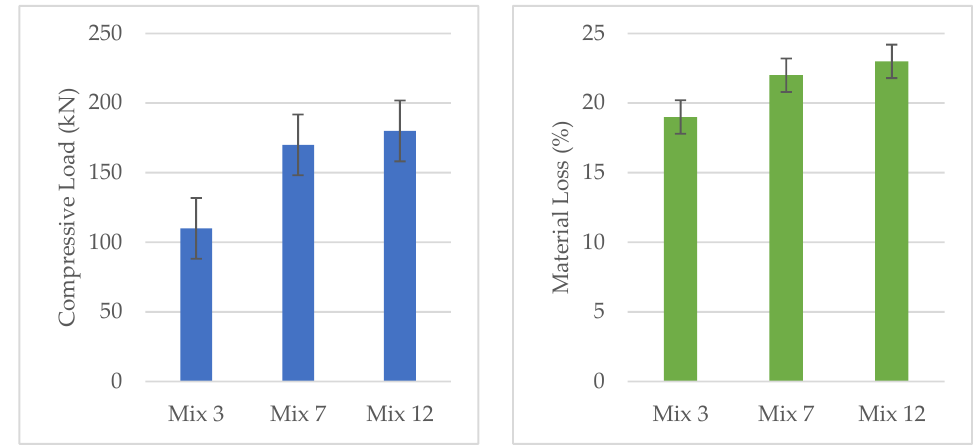
Figure 6. Results of compression and material loss based on the principle of Cantabro test.